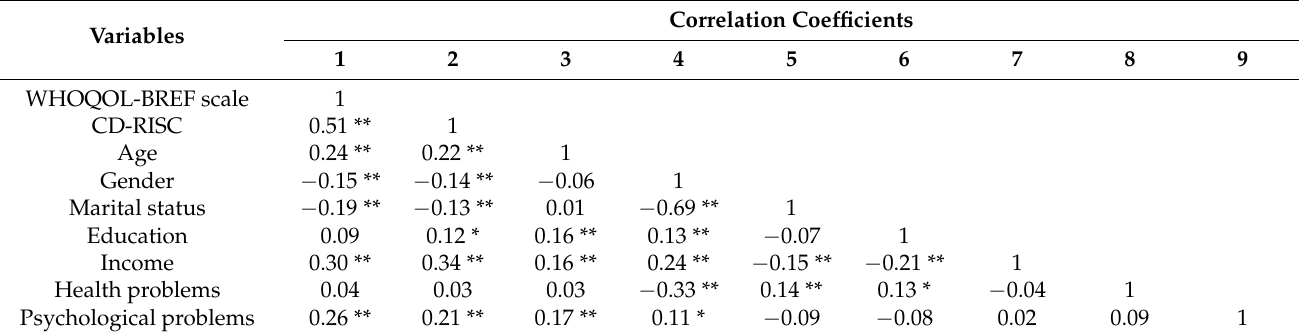
Table 5. A matrix of the Spearman correlation between the WHOQOL-BRE, personal characteristics, and resilience among the study